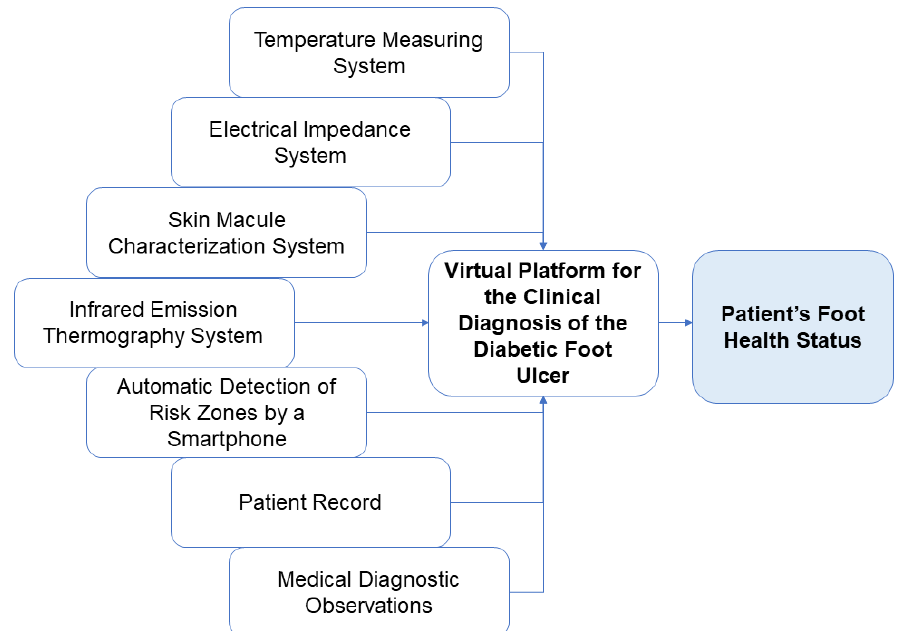
Figure 4. Diagram of the virtual platform for the national diabetic foot ulcer data. The virtual platform show a dashboard where all the information is centralized for each one of the systems gives; after that, all the information generated a single register into the database with the purpose of defining the patient’s foot health status.